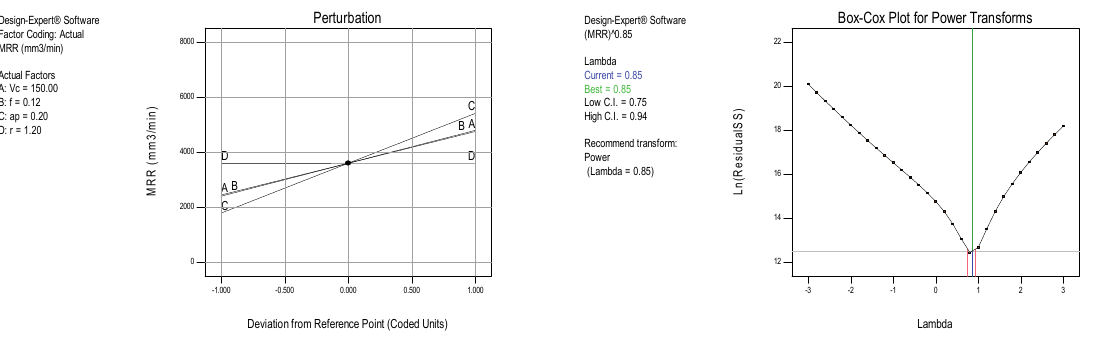
Fig. 6. Perturbation plot for MRR Fig. 7. Normal plot of residuals for MRR